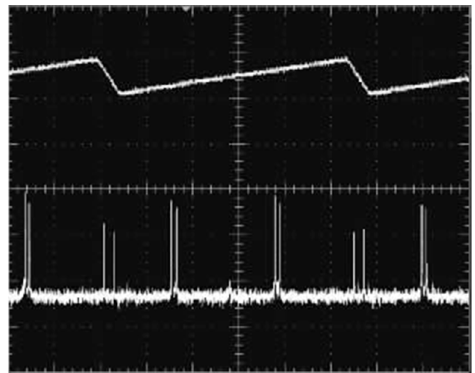
Figure 5. Oscillating spectrum of dual-frequency laser [21].